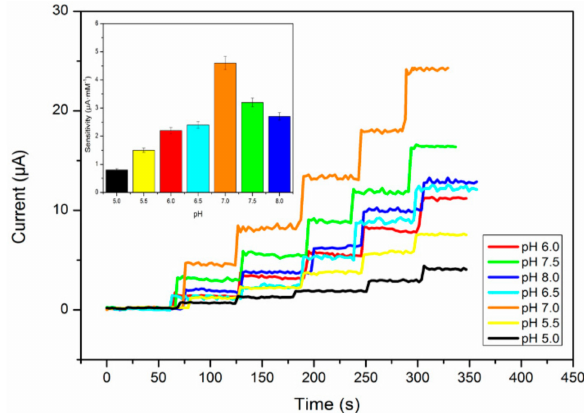
Figure 5. Amperometric response of GOD-BLG-PtAuPd-RGO/GC electrode upon successive additions of 1 mM glucose into 0.1 M PBS solution under stirring at operating voltage of 600 mV with different pH values from 5.0 to